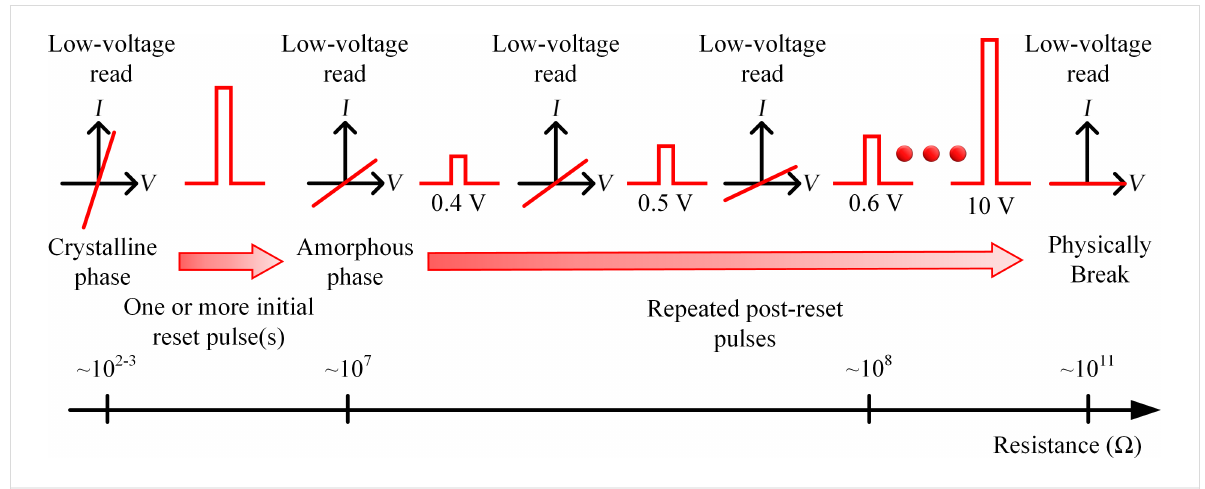
Figure 3: Schematic of the measurement sequence. One or more pulses were applied to initially reset the crystalline cells. Then, a sequence of pulses with increasing amplitude (from 0.4 to 10 V in 0.1 V increment) were applied until further re-amorphization. Eventually, physical breaking occurred with loss of electrical connection. Low-voltage read operations were performed before and after each applied pulse.